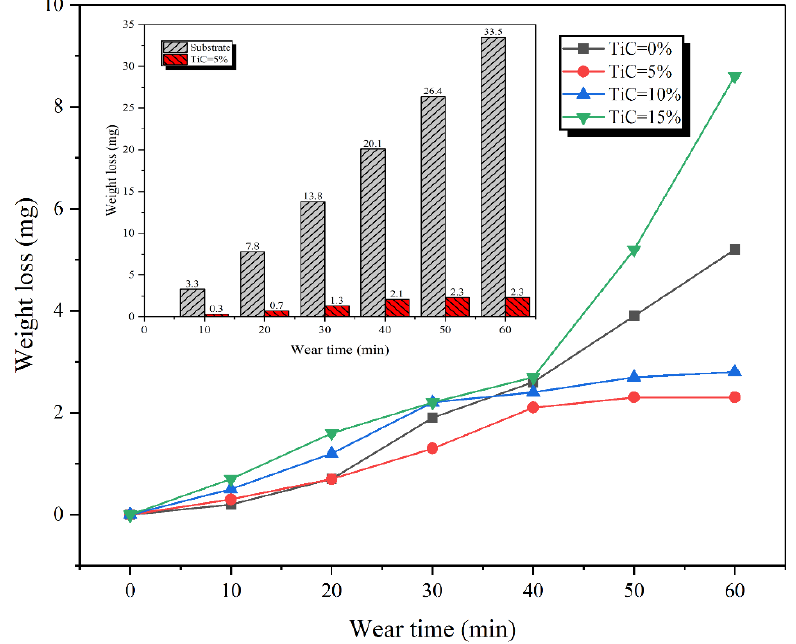
Figure 10. The relationship curve of wear loss weight with wear time of claddings with different TiC contents and substrate.